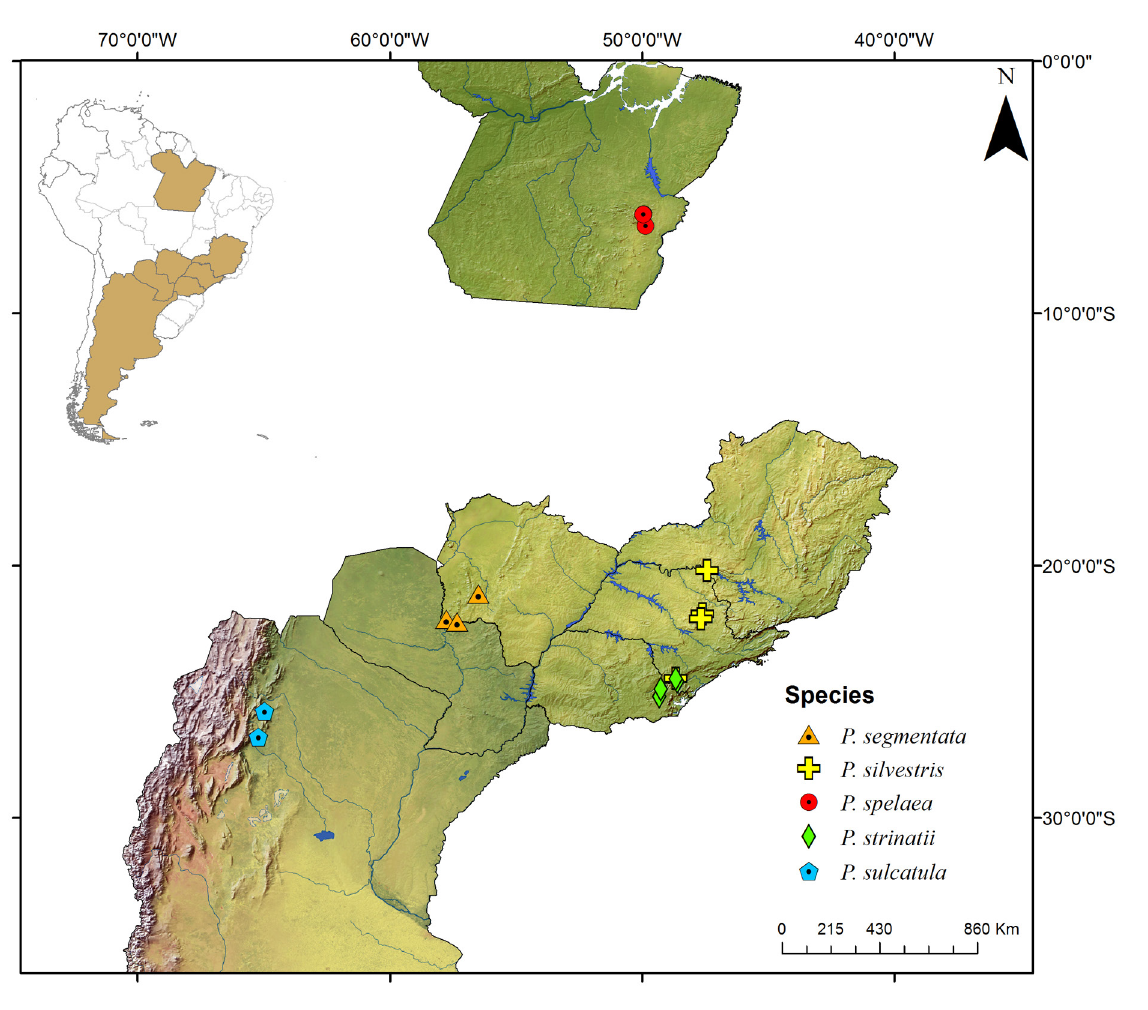
Fig. 188. Distribution map of the species Pseudonannolene segmentata Silvestri, 1895, P. silvestris Schubart, 1944, P. spelaea Iniesta & Ferreira, 2013, P. strinatii Mauriès, 1974, and P. sulcatula